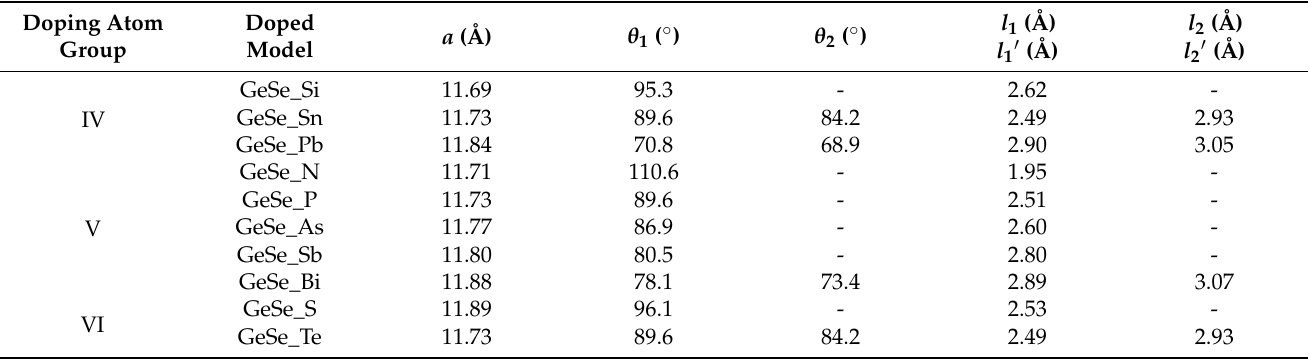
Table 1. The parameters of the doped GeSe monolayer with the group-IV, -V, and -VI atoms (Si, Sn, Pb, N, P, As, Sb, Bi, S, and Te): Lattice parameter ( a ), bond angles ( θ 1 and θ 2 ), and bond lengths ( l 1 , l 2 ,